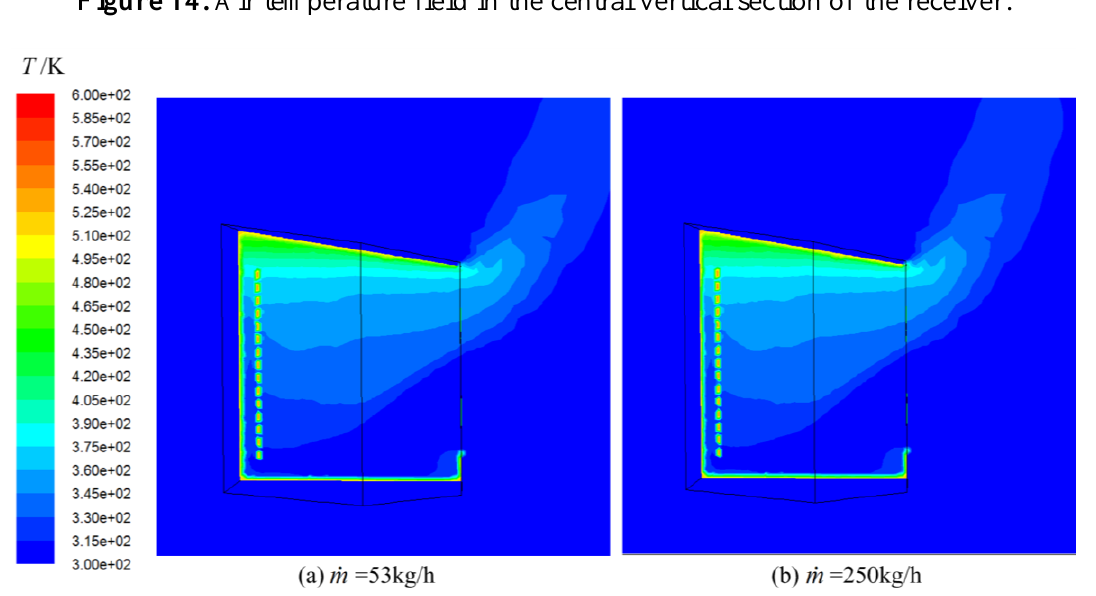
Figure 14. Air temperature field in the central vertical section of the receiver.